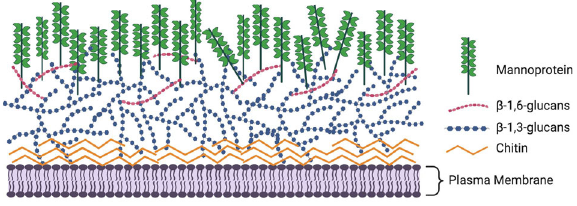
Fig. 1 Schematic model of the fungal cell wall. This model shows the three basic components of the cell wall present in almost all fungal pathogens. Mannoproteins have polymers of mannose that decorate the proteins through O-linkages or N-linkages and are predominately found in the outer portion of cell wall. β -glucans are the most abundant constituent of the cell wall and tend to be in the middle with β -1,3-glucans forming the scaffold and β -1,6-glucans forming the branches, while chitin is found in the inner portion of the cell wall and linked to β -1,3-glucan. Other components of the cell wall in some fungi include α -glucan, galactomannan, chitosan, and melanin. In addition, the cryptococcal capsule is linked to the cell wall. Figure created with